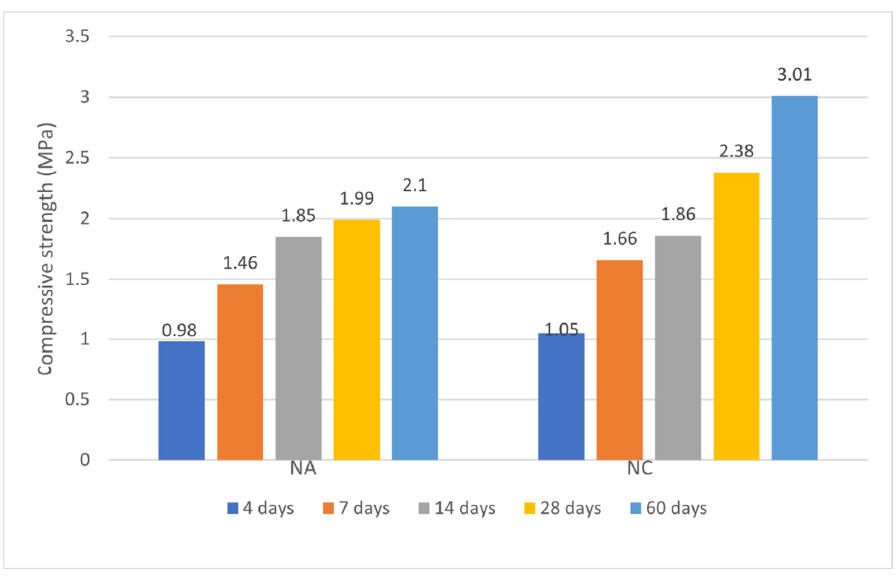
Figure 15. Angers TC testing for 10% and 14% of A2.